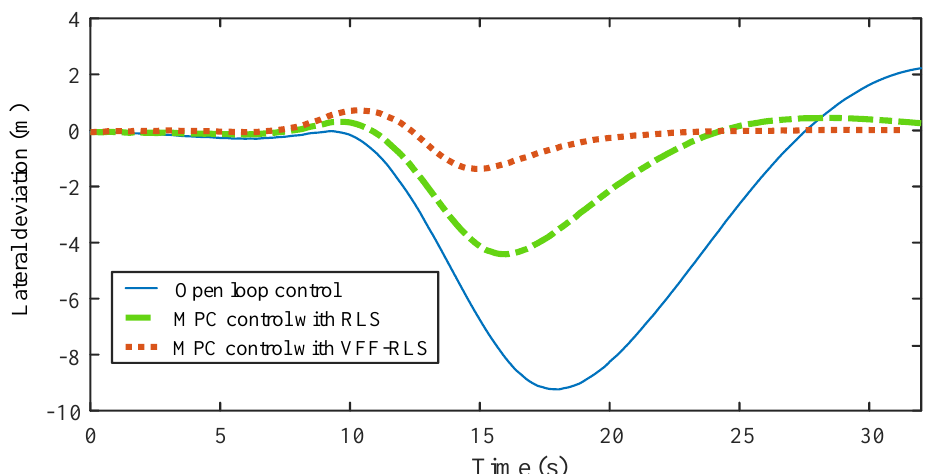
Figure 11. Steering wheel angle under Scenario A.